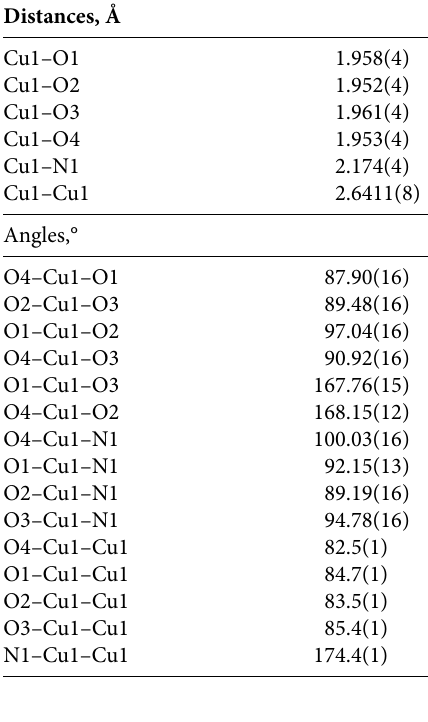
Table 2. Selected Bond lengths and angles of complex Distances, Å